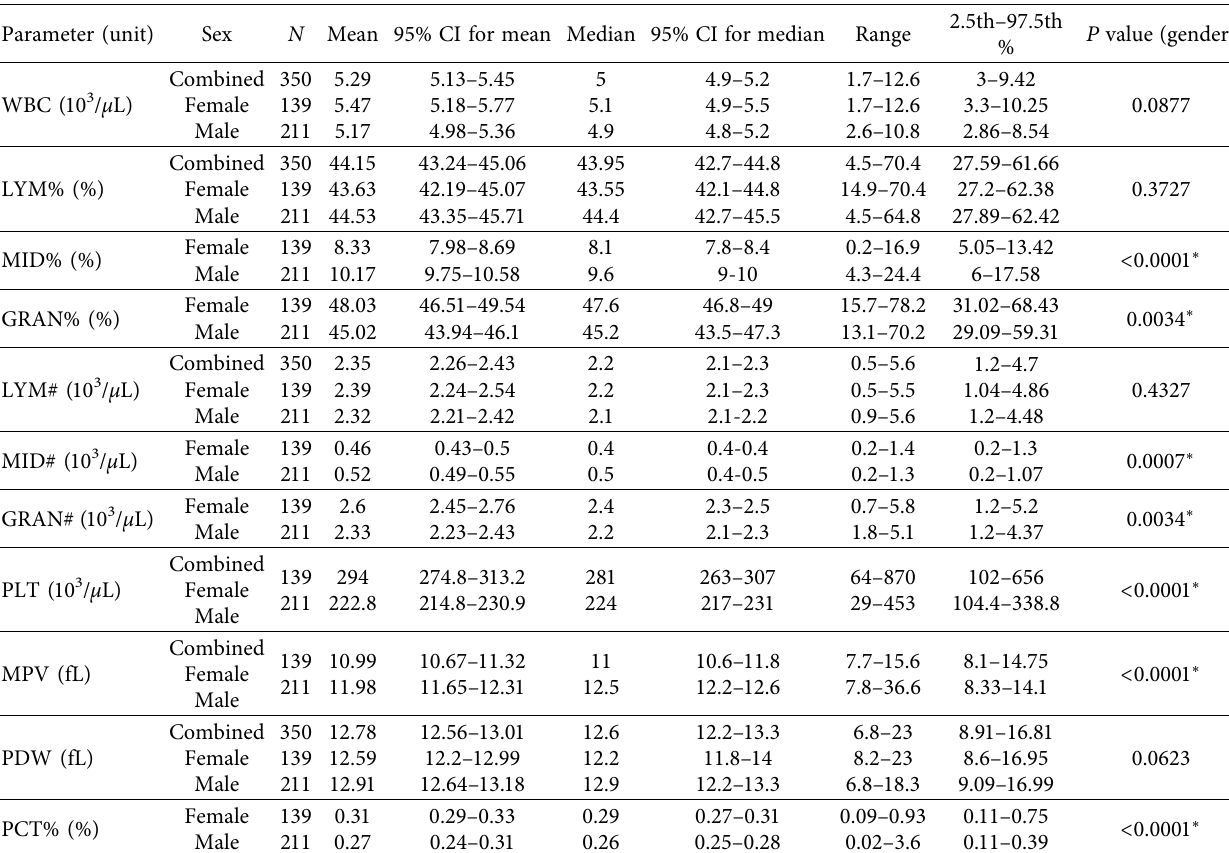
Table 4: Calculated hematological (WBC and platelet) reference interval for the screened population. Parameter